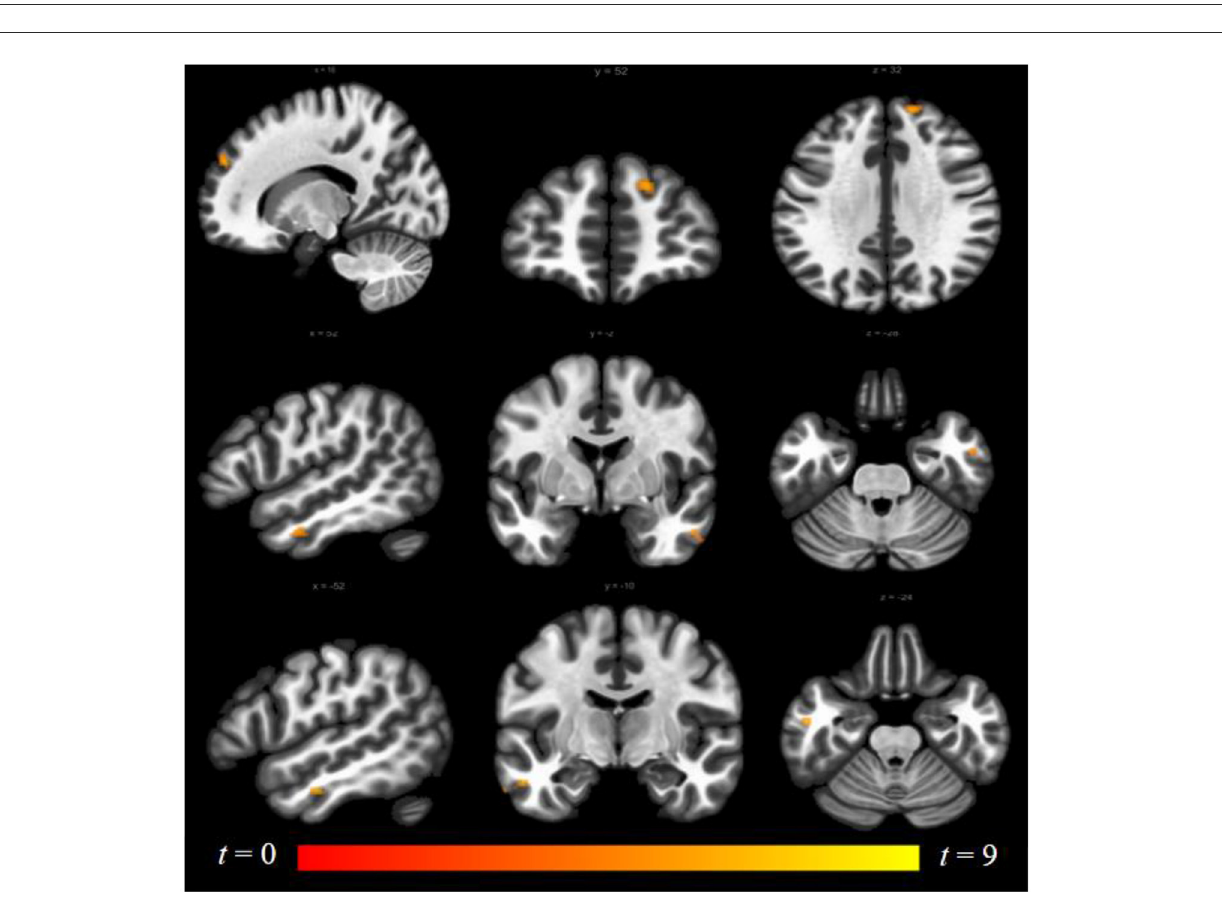
FIGURE6 Within-group differences between follicular phase and luteal phase. The hot color scale indicates higher right insula–right frontal pole, left and right middle temporal gyrus resting-state functional connectivity (RSFC) in the follicular than luteal phase. Coordinates are given in MNI space and statistics in t